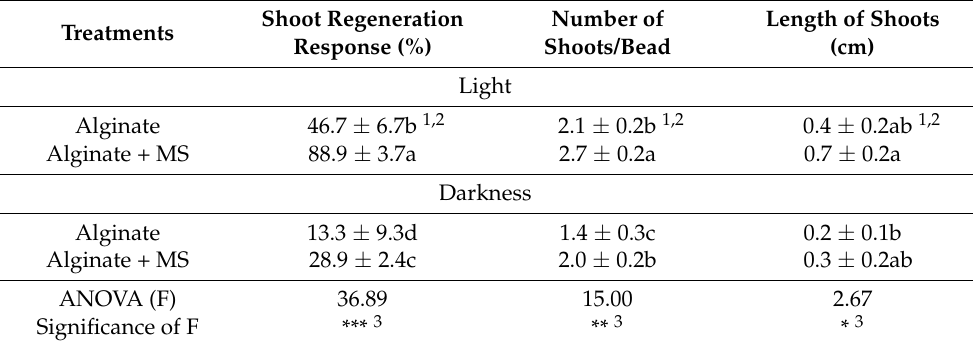
Table 1. Effect of MS nutrient medium addition in the encapsulation matrix (with 2.5% sodium alginate and 50 mM calcium chloride) on artificial seed germination of G. jasminoides , under light or in darkness, after 4 weeks of